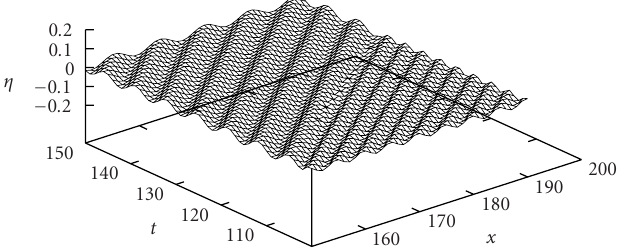
Figure 5.8. Wave motion due to impulse when t = 100 to 150, x = 150 to 200; (cid:1) = 0 . 01, D = 0 . 5.